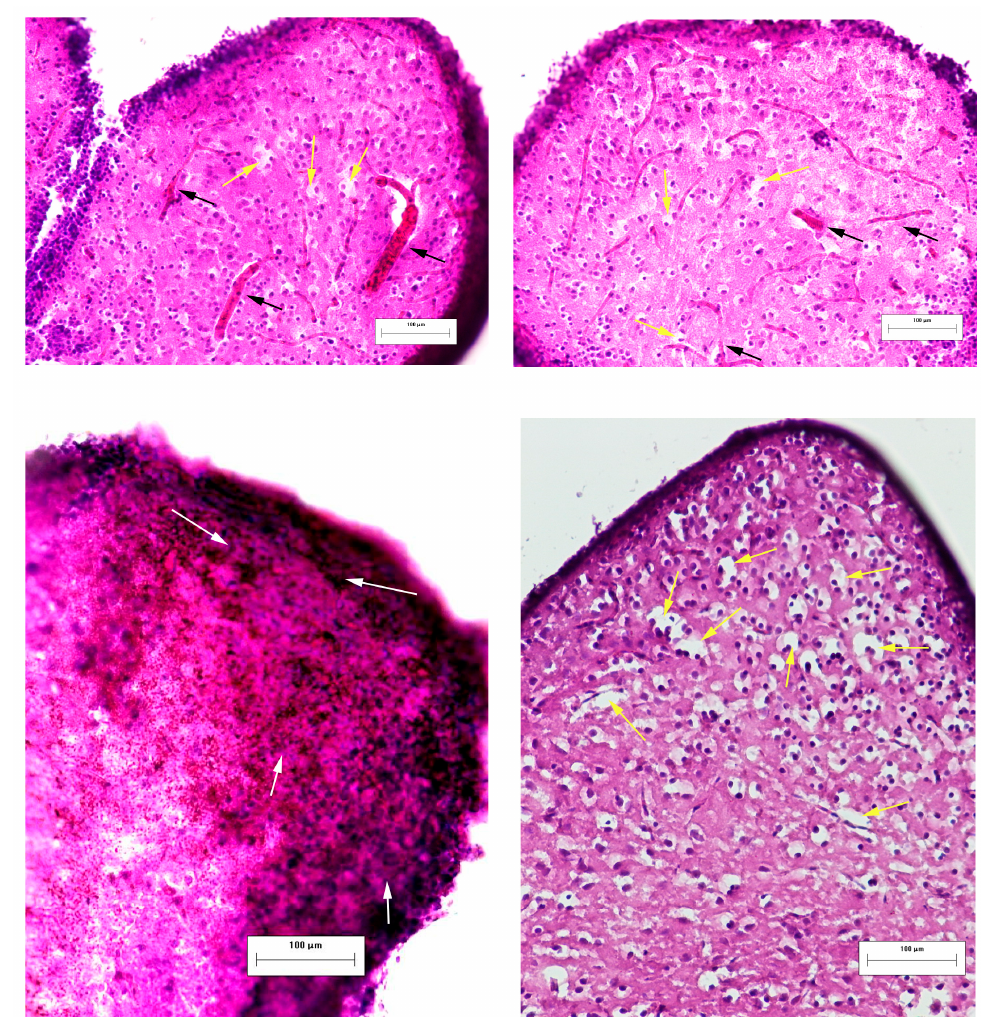
Figure 5. Effects of laser-induced lesion (TBI model) on the neuromorphology of the telencephalon one day after the injury in zebrafish. Representative images of brain cryosections of fish from the TBI group stained with hematoxylin and eosin. Black arrows show dilated vessels, white arrows—hemorrhage, yellow arrows—edema. Magnification, ×200.